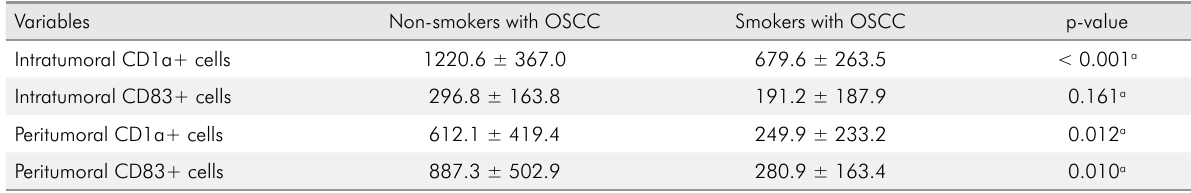
Table 2. Quantification of intra and peritumoral CD1a+ and CD83+ cells (cells/mm 2 ± standard deviation) in the different groups with oral squamous cell carcinoma.